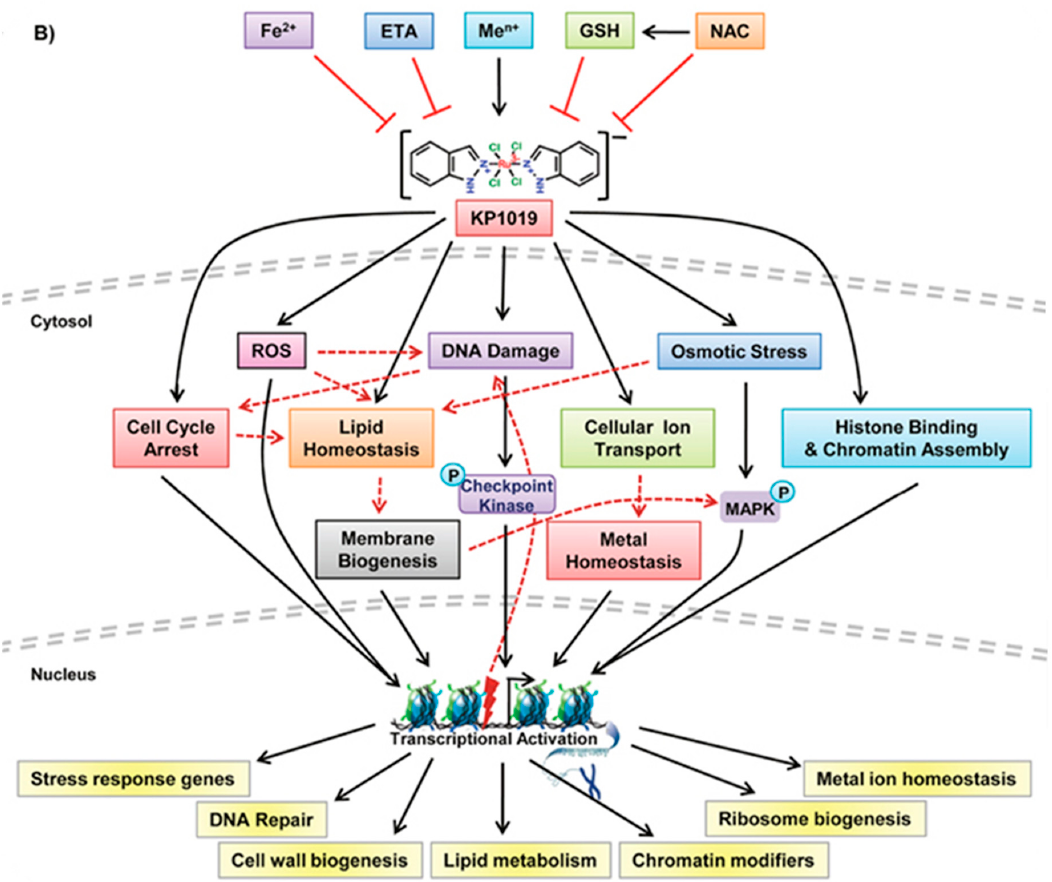
Figure 4. A proposed model depicting the mode of action of KP1019. Reproduced from Ref. [113].